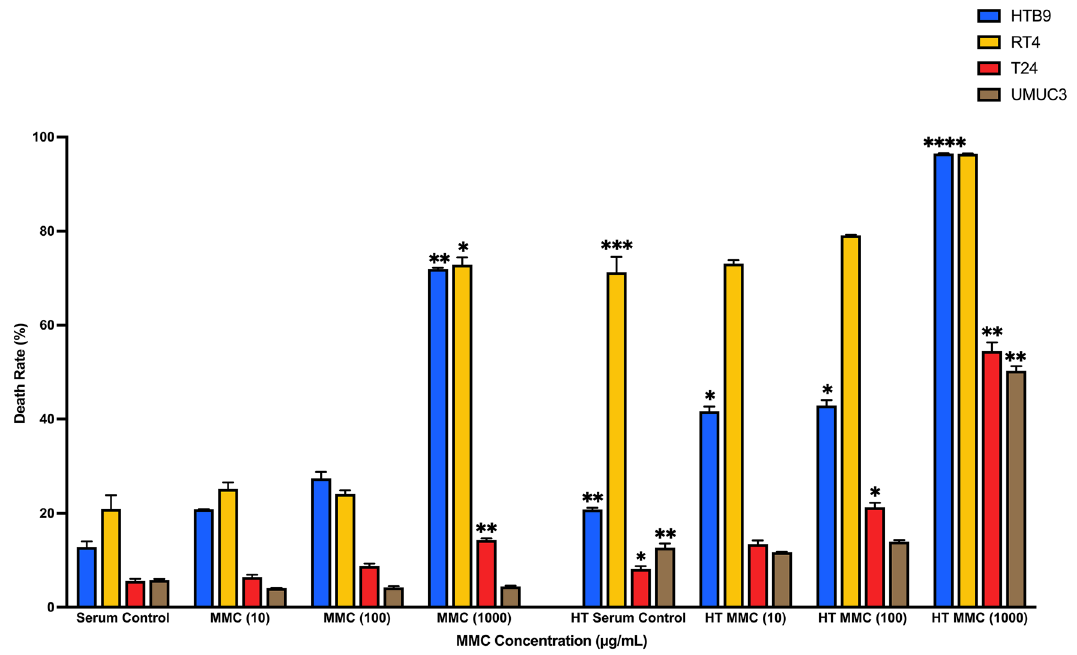
Figure 5. Comparison of normothermia- and hyperthermia-MMC induced cytotoxicity at different concentrations by flow cytometric analysis. HTB9, RT4, T24 and UMUC3 cell suspensions were incubated at 37 °C and 43 °C at 10 µg/ml, 100 µg/ml and 1000 µg/ml MMC. Death rates of the 4 bladder cancer cell lines were calculated by FlowJo (version 10.4). Data are presented as the mean ± SD. Different strategies were compared with serum control of the same cell line. *p < 0.05 and **p < 0.01, ***p < 0.001, ****p < 0.0001, t test (n = 3, three independent biological replicates were performed for all the